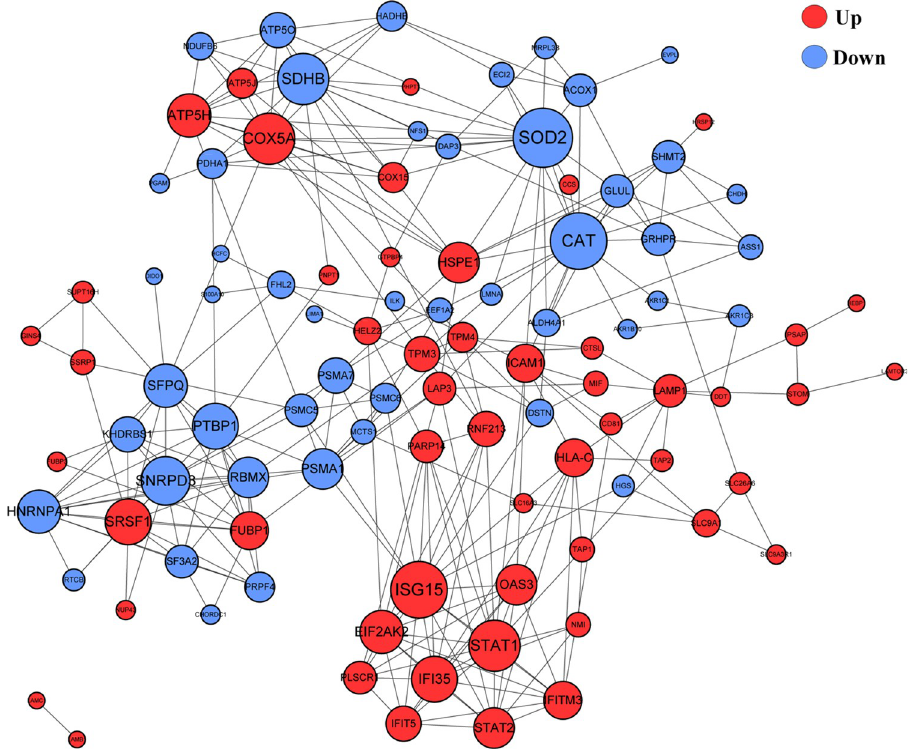
Fig 4. Association networks of DEPs using Cytoscape. PPI network profiles the interplay of the identified host proteins. The color of the circle represents upregulated proteins (red) and downregulated proteins (blue) respectively. The size of the circle represents the significance of the